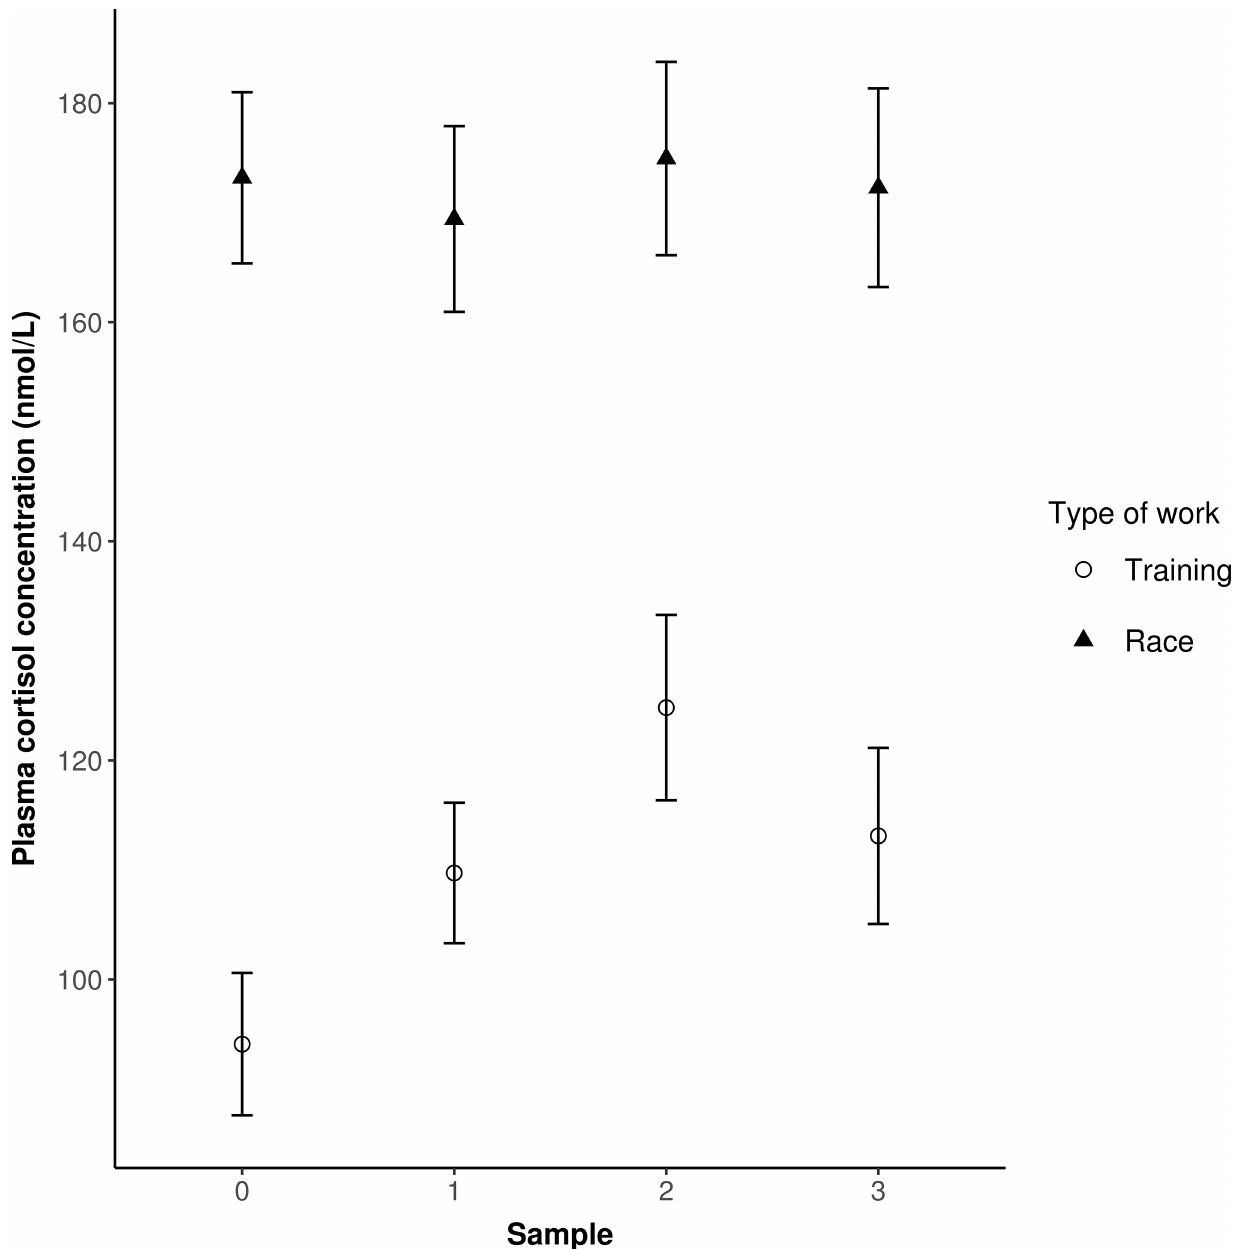
Fig 2. Plasma cortisol levels of Standardbred racehorses (n = 8) before and after training and trotting race (means ± SEM). 0: Sample 0 = before warming up (baseline), 1: Sample 1 = afer warming up, 2: Sample 2 = immediately after the end of exercise, 3: Sample 3 = after a 30-min recovery. The distance covered during training and race was 8,000–9,000 and 2,300 m, respectively. The time lag between the first and the last sample ranged between 52 and 60 min.